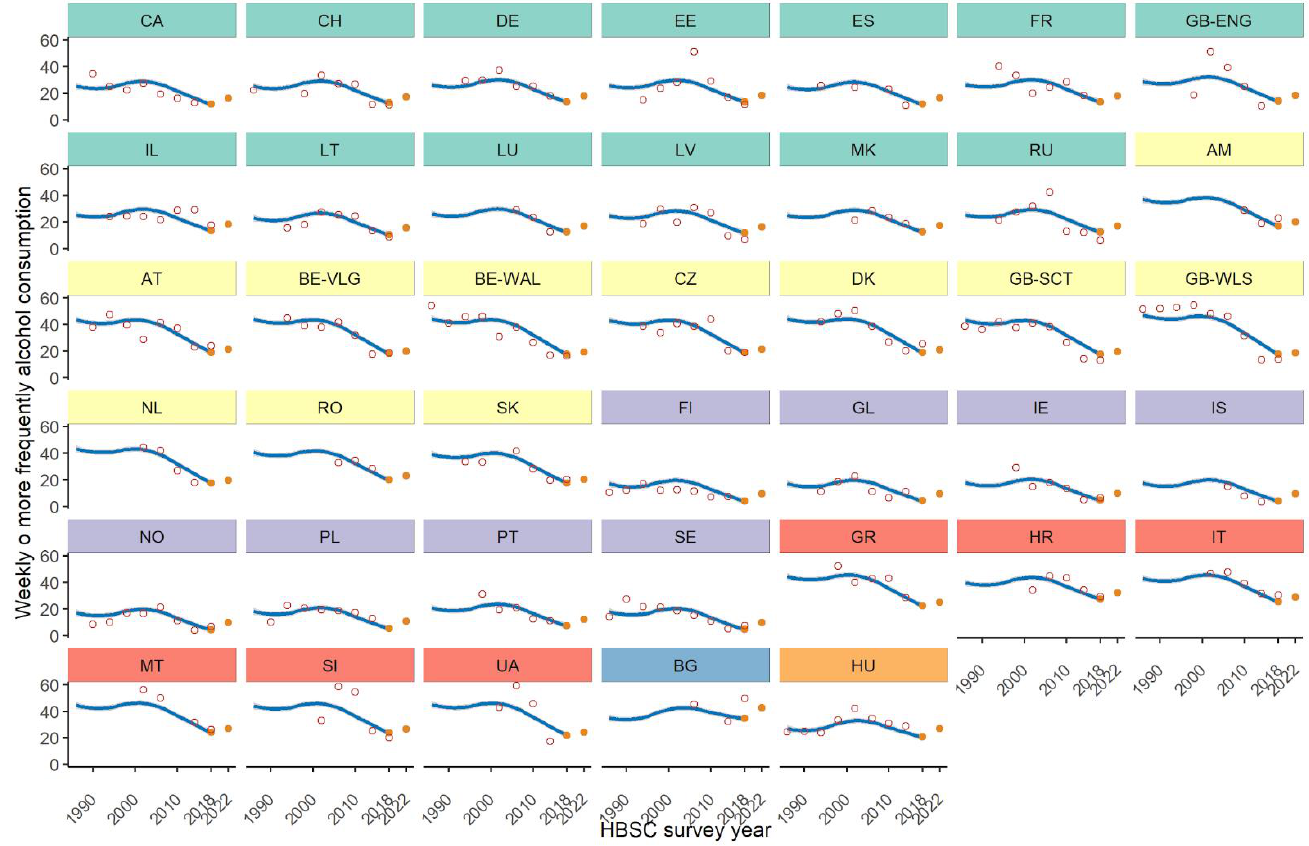
Figure 1. Trends (empty circles) and estimated (full circles for 2017/18 and 2021/22 waves) preva- lence, (%), by country. Countries are grouped according to clusterization (different colours). Girls.